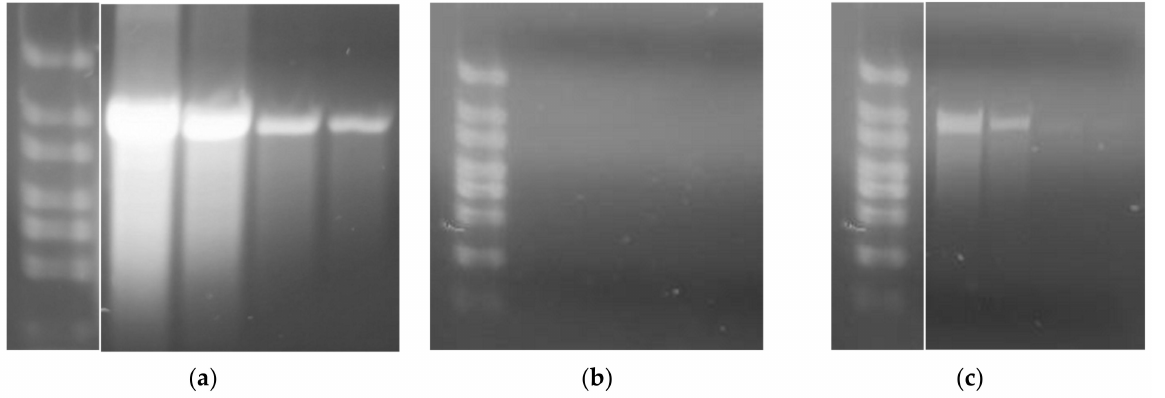
Figure 24. Agarose gel images with dilution steps 1:10, 1:20, 1:100 and 1:200 of the ( a ) feed (pre dilution), ( b ) permeate, and ( c )